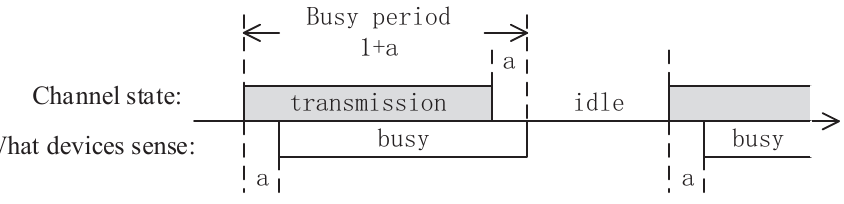
Figure 2. Channel state in a non-persistent carrier sense multiple access (CSMA)